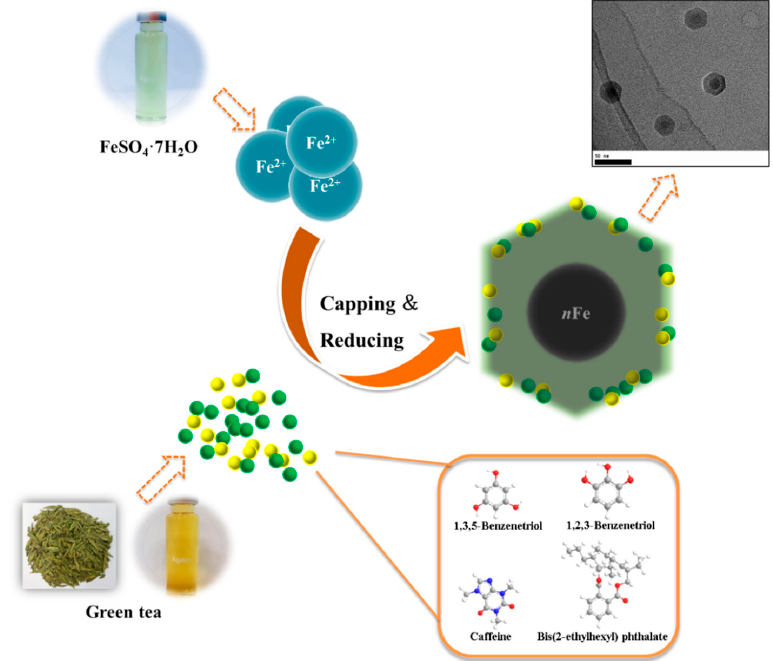
Figure 8. Proposed mechanism of the green tea synthesis of n Fe.